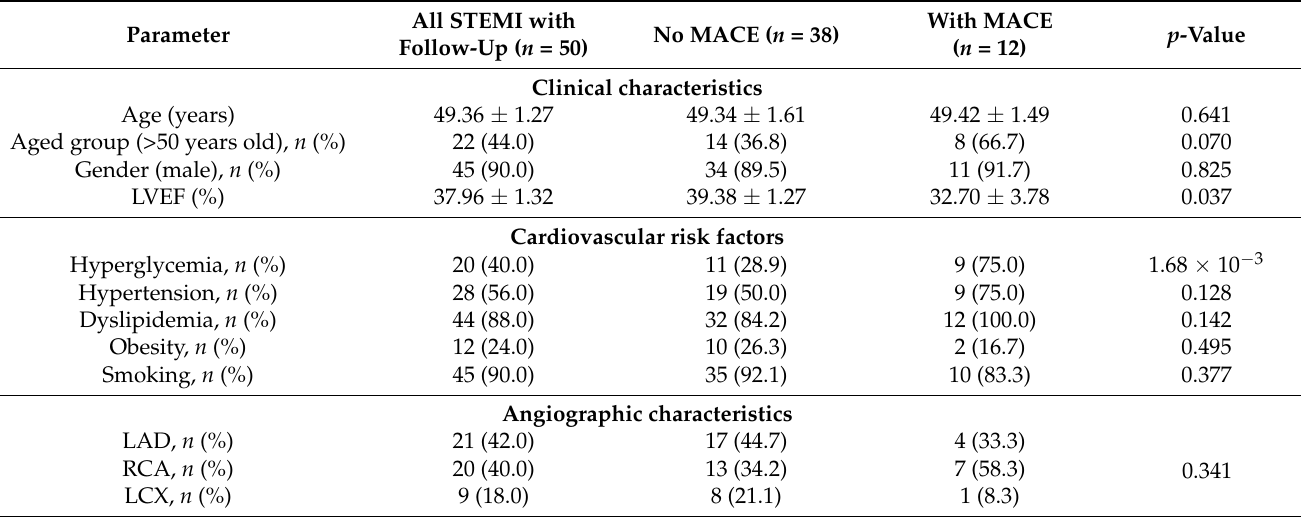
Table 1. Distribution of clinical data, CVD risk factors, and angiographic characteristics of ST-segment elevation myocardial infarction (STEMI) patients overall and grouped by the occurrence of subsequent major adverse cardiovascular events (MACE) at 6-month follow-up.